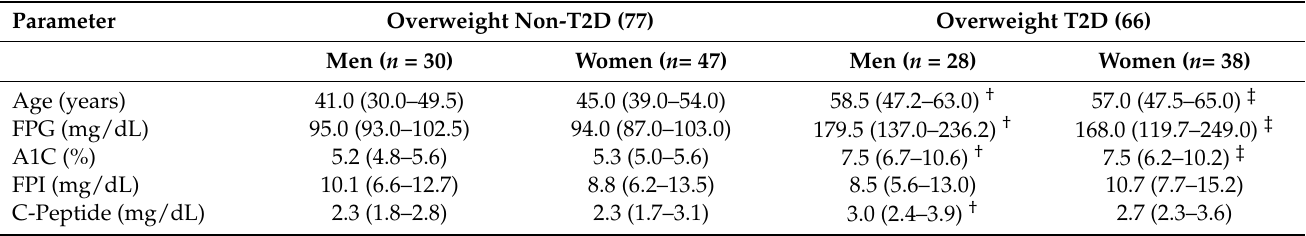
Figure 3. Correlation between XO activity and FPG and hemoglobin-A1C levels in T2D and non-T2D subjects with BMI ≥ 25 kg/m 2 . ( A ) XO activity vs. FPG in T2D patients. ( B ) XO activity vs. A1C in T2D subjects. ( C ) XO activity vs. FPG in non-T2D. ( D ) XO activity vs. A1C in non-T2D subjects. The P values were estimated by Spearman’s correlation analyses. Abbreviations: Xanthine oxidase (XO), fasting plasma glucose (FPG), hemoglobin-A1C (A1C). Table 2. Sex-based analyses of overweight T2D patients and non-T2D